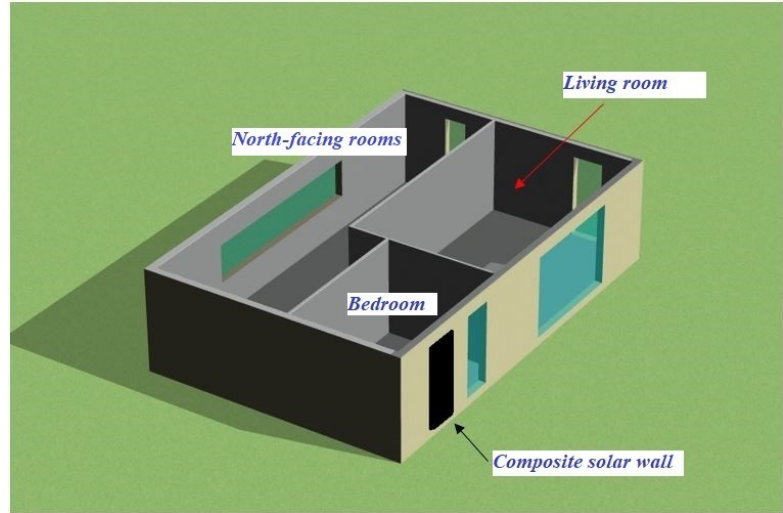
Figure 1. Schematic depiction of the detached single-family